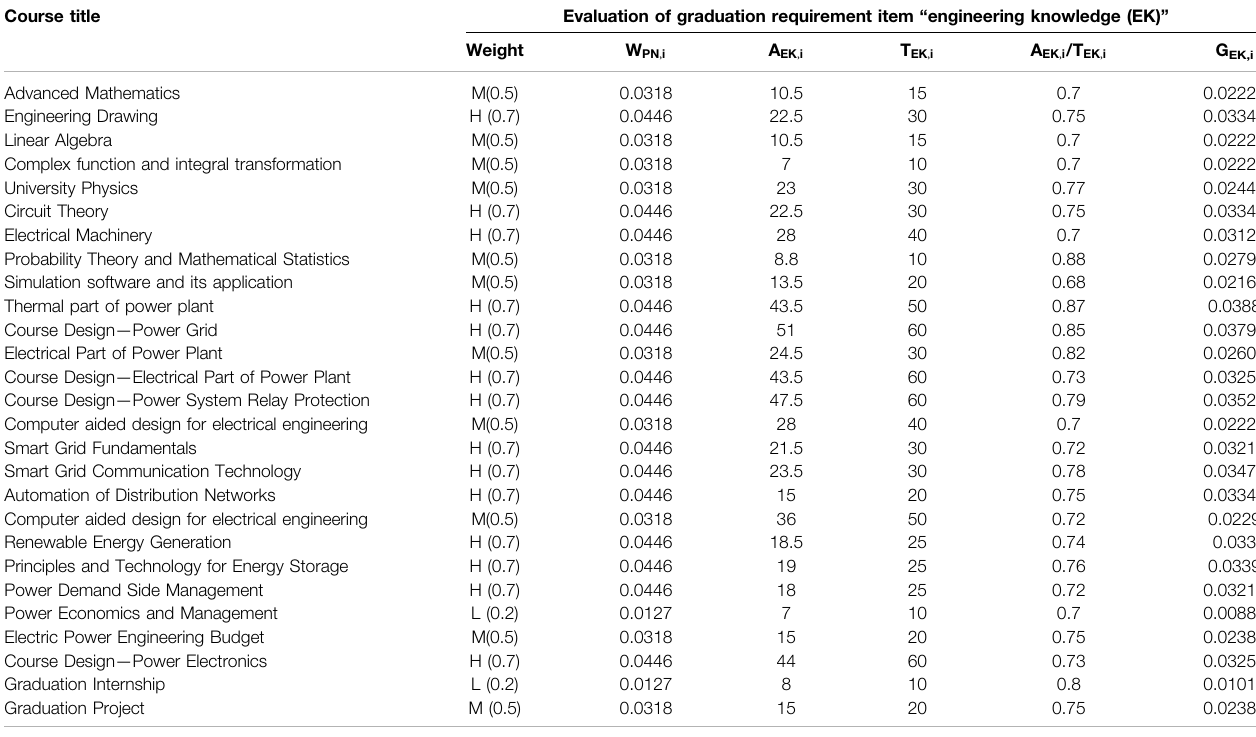
TABLE 8 | Calculation of grading value of graduation requirement ‘ EK ’